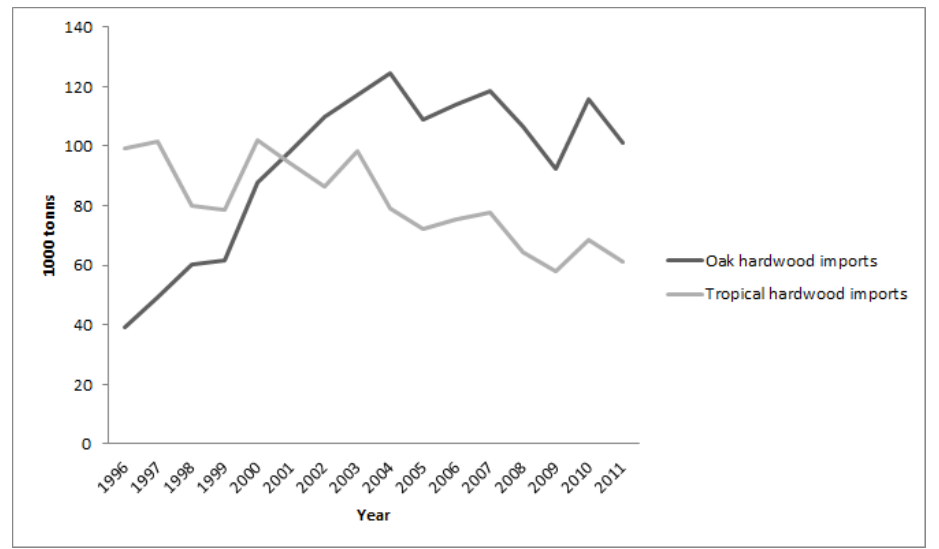
Figure 3. UK’s oak imports vs. tropical timber imports. Source: UN COMTRADE [23] trade data